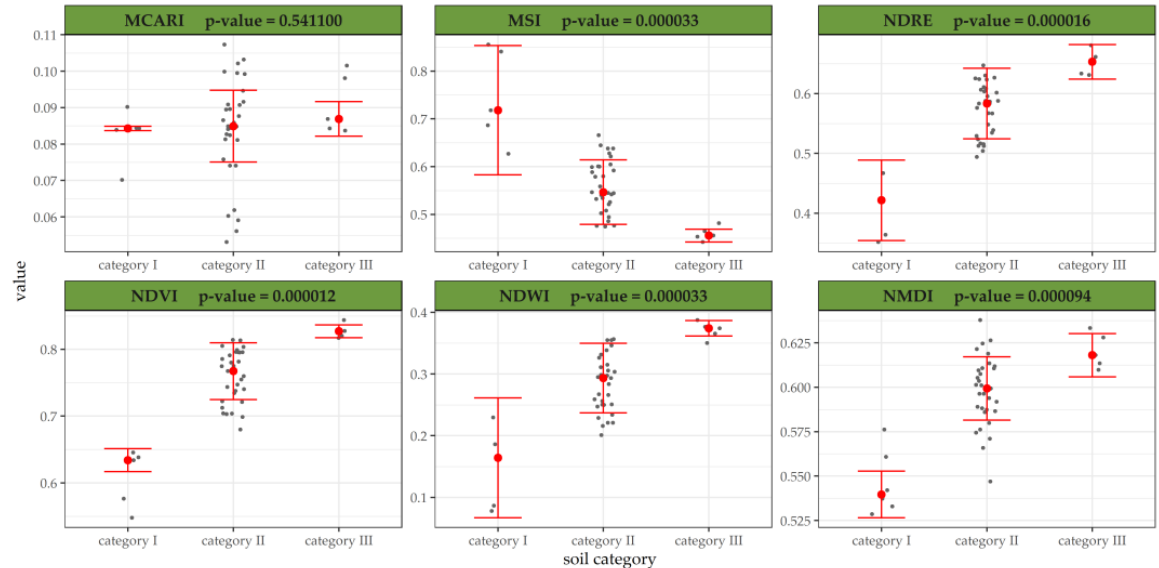
Figure 4. Comparison of obtained results for selected vegetation indices in each soil category (median +/ − MAD) and p -value in the Kruskal–Wallis test.